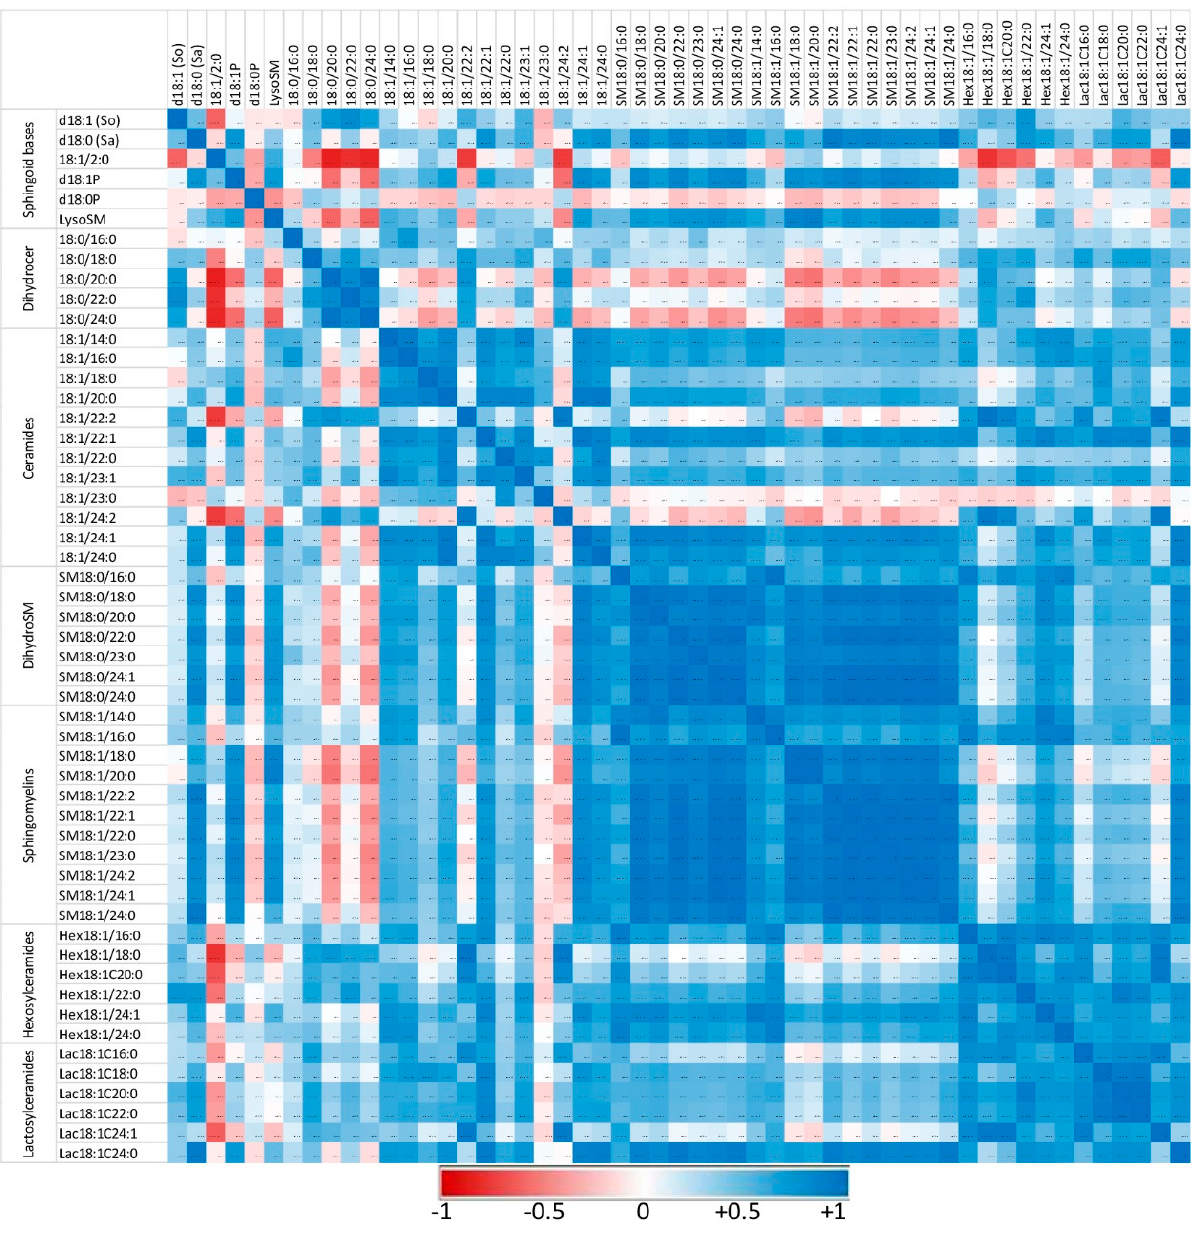
Figure 5. Correlation heatmap of sphingoid bases and sphingolipids with 14 to 24 carbon fatty acid chain lengths detected in the peritoneal cells of control mice that received PBS. Correlations are presented by sphingolipid class and by increasing size. The values of the Pearson coefficients of correlations observed among all sphingolipids assayed in this study are reported in Table S5. Blue represents a positive correlation, red represents a negative correlation, and white represents no correlation.